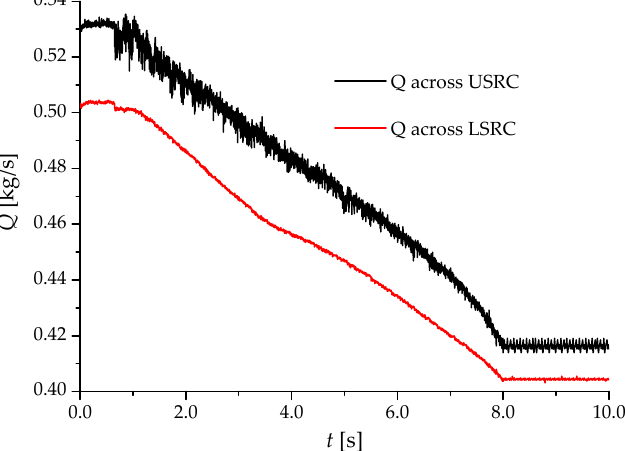
Figure 7. Numerical simulation of the mass flow rate Q across the USRC and LSRC for the Francis turbine under a load rejection condition.